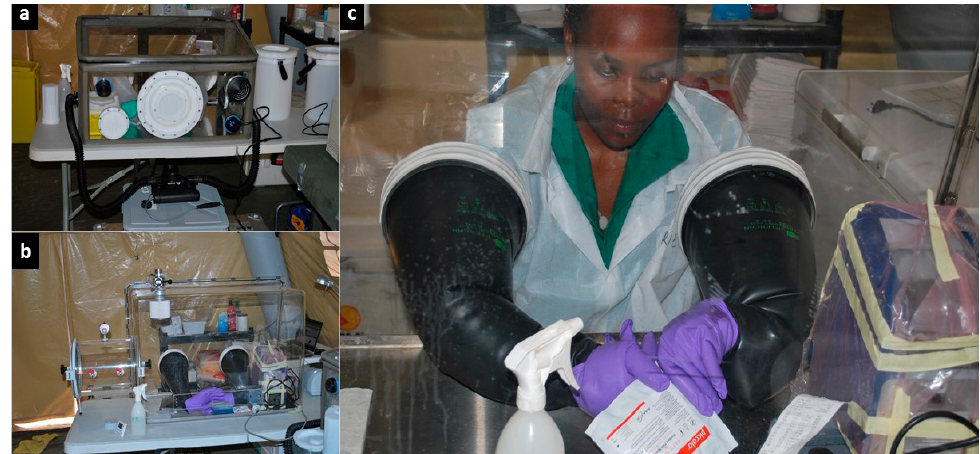
Figure 2. Two portable negative-pressure gloveboxes. ( a ) The smaller glovebox was used for inactive Ebola virus in patient samples, perform malaria tests, and monitor biochemical parameters with the handheld blood analyser. ( b , c ) The larger glovebox was used to monitor biochemical parameters with the Piccolo Xpress and to prepare the Biofire Filmarray cassette for Ebola diagnostics (not shown).